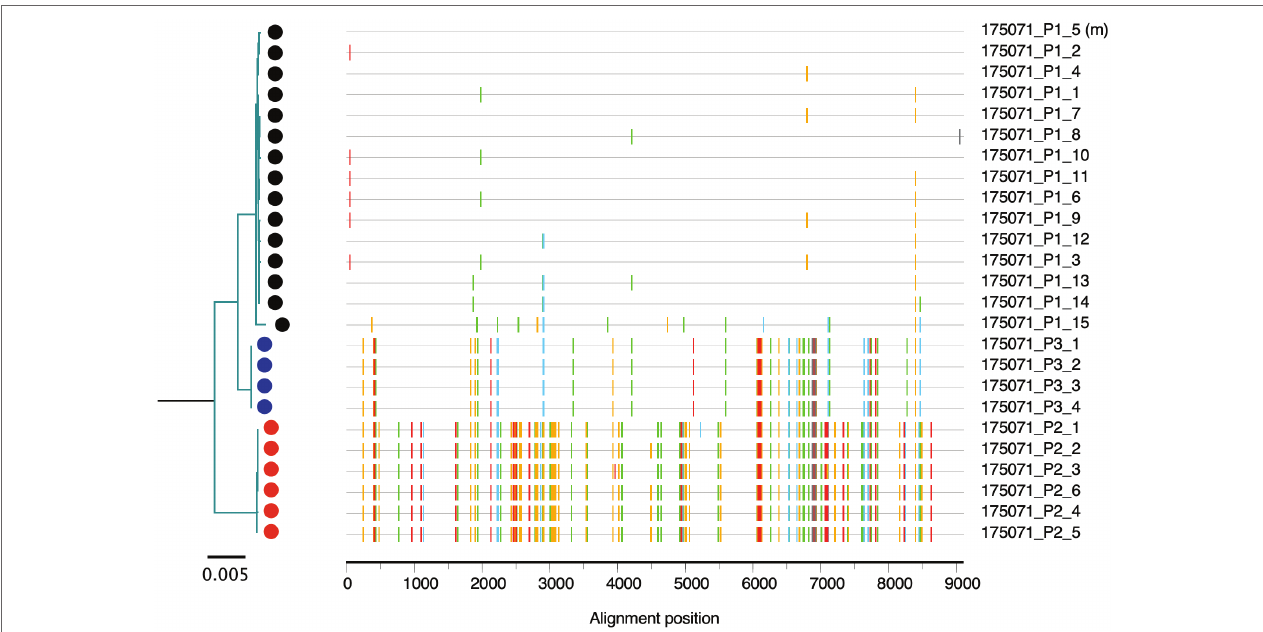
FIGURE 2 | Multi-variants transmission. The phylogenetic tree and aligned sequence highlighter analysis show 175,071 contains three viral populations at the first visit time-point (EDI = 41). Tick marks indicate nucleotide change from the master at same position according to the alignment. The color codes are as follows: A: green, T: red, G: yellow, C: blue, and gaps: